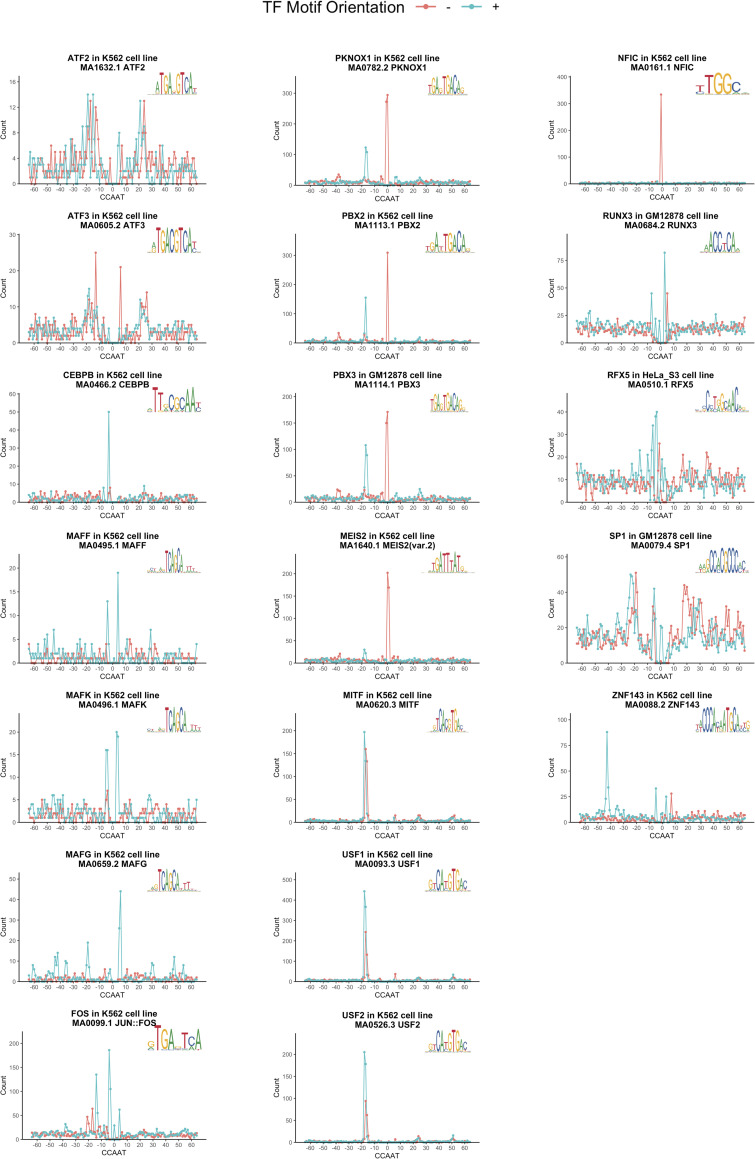
Positional Bias motif distances plot.Distribution of distances between the center of positive TF motifs and the middle A of CCAAT-box. Data obtained from PscanChIP output, given co-binding peak summits, centering on CCAAT and picking the relative TF matrix. Colors state motif direction with respect to the plotted positional weight matrix.